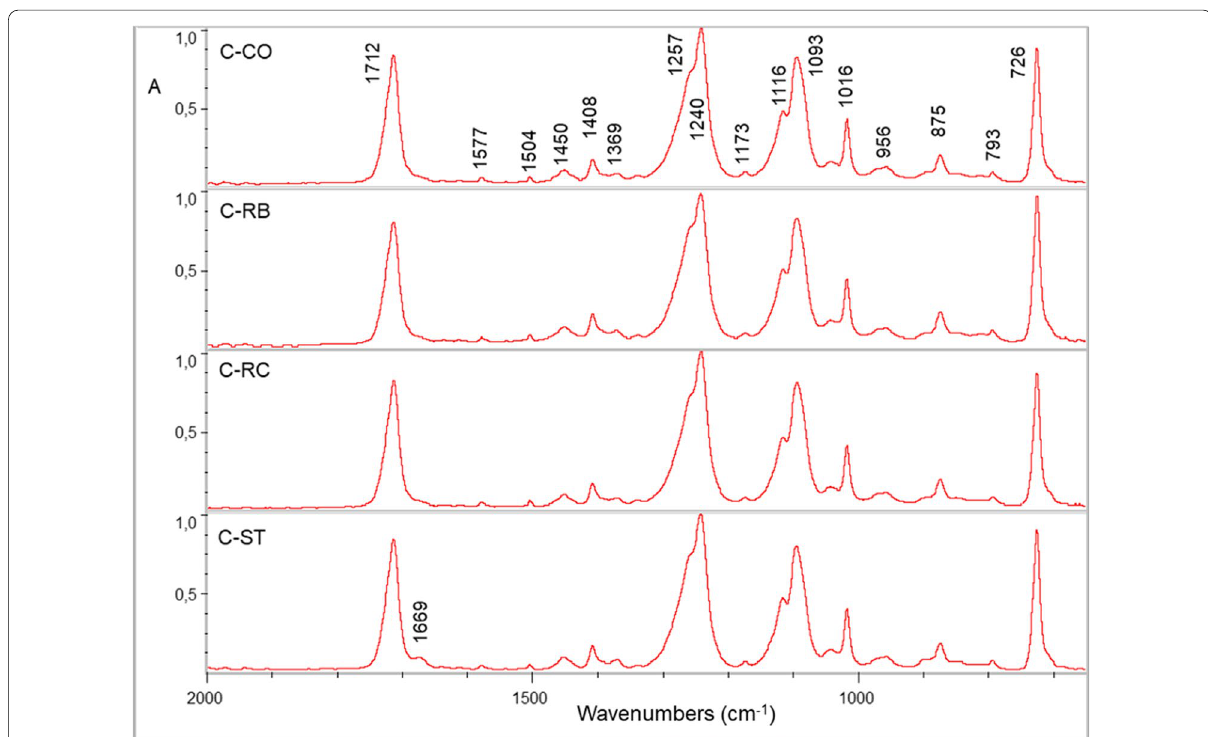
Fig. 2 ATR-FTIR spectra of Clear Aligner (C) before (CO) and after treatments with Retainer Brite (RB), Retainer Cleaner (RC) and Steraligner (ST) cleaners. An additional peak appeared at 1669 cm − 1 after ST cleaner (expanded 2000–650 cm − 1 range, absorbance